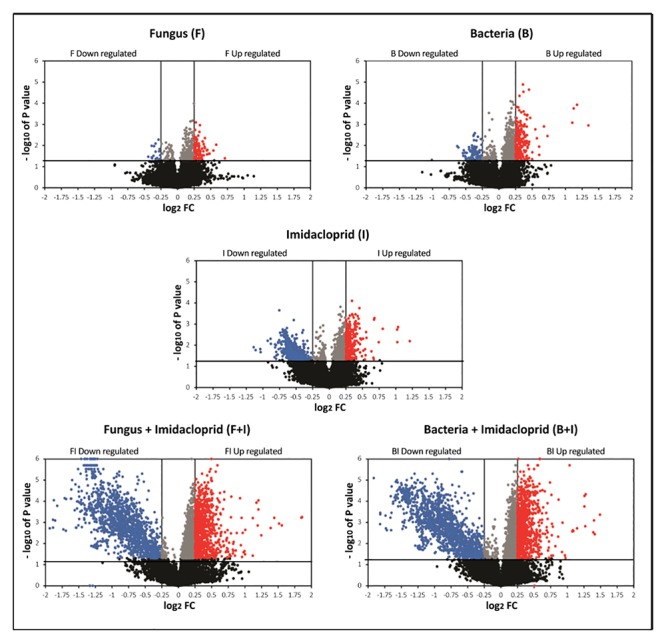
Microarray volcano plots showing differing numbers of passing array positions in F (fungi), I (imidacloprid), B (bacteria), F+I (fungus + imidacloprid), B+I (bacteria + imidacloprid) treatments.Red and blue spots indicate significant upregulated and downregulated array positions with +/- 2-fold change (FC) upregulation and downregulation, respectively.